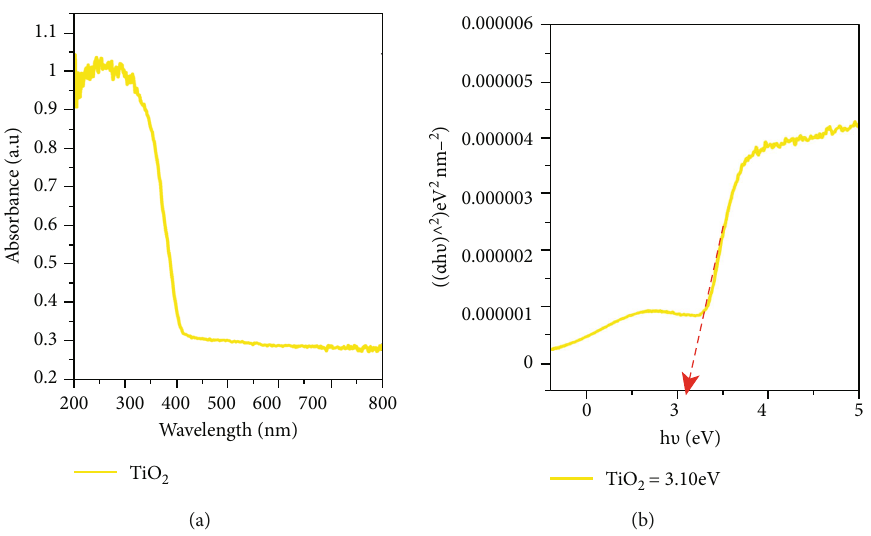
Figure 8: (a) Spectrum of UV-DRS absorption of synthesized TiO